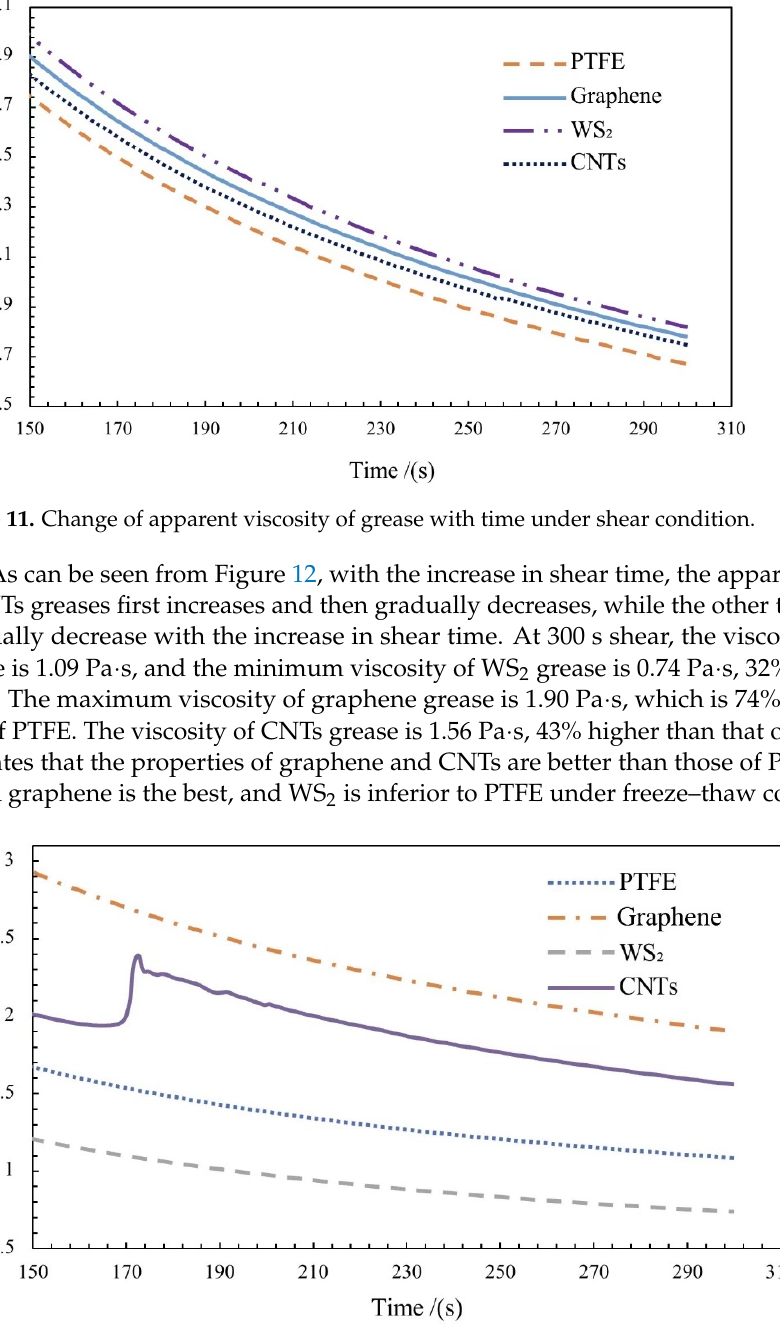
Figure 12. Changes of apparent viscosity with time of various freeze–thaw greases under shear con- ditions.